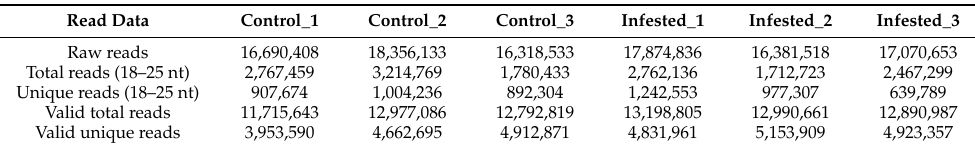
Table 1. The valuation statistics of sample sequencing